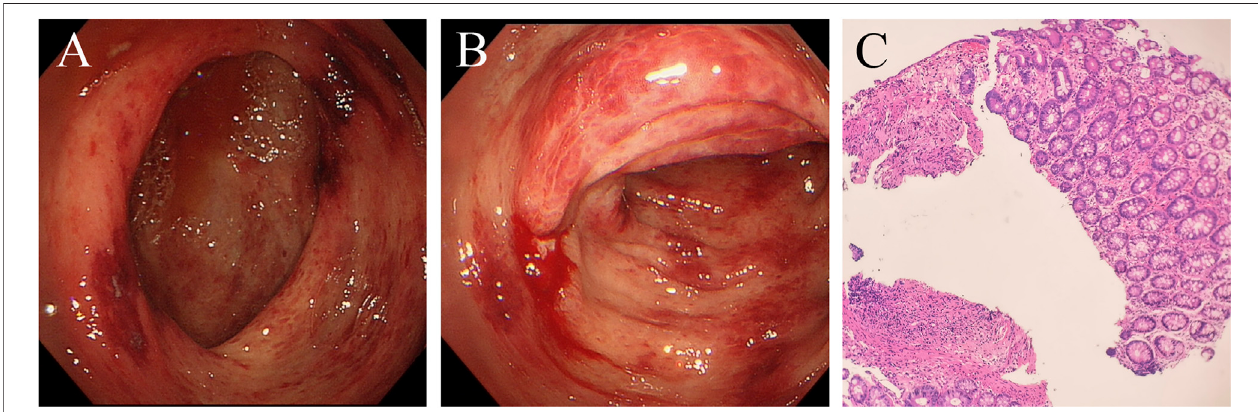
FIGURE 2 | Colonoscopy shows oedema, erythema and bleeding ulcers from the ileocecal area to the sigmoid colon. Formation of the pseudomembrane and necrosis were not found. (A) ileocecal area. (B) transverse colon. (C) Pathological examination of the transverse colon. Mucosal ulcers are formed, and lamina propria eosin stain,